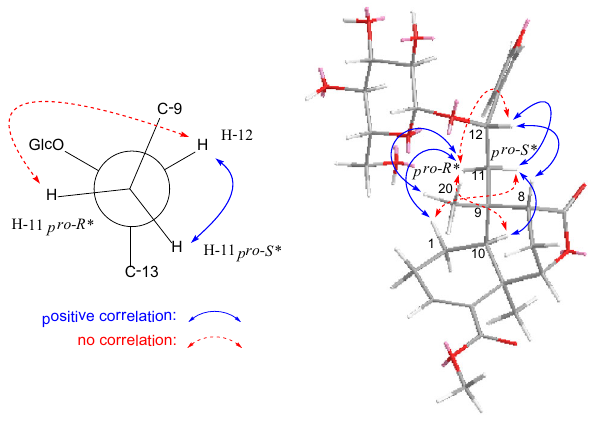
Fig. 1 Key ROESY correlations of 1